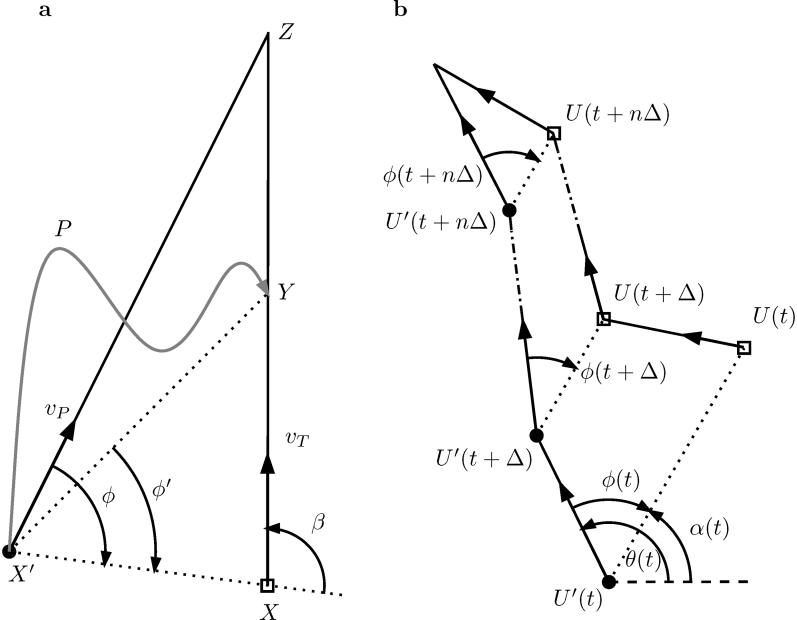
Time-Optimal Strategies to Intercept a Target(A) The target (square), which starts at position
X, moves in a straight line at a constant speed
v
T. The pursuer (solid disk), which starts at position
X′, moves at a constant speed
v
p. The straight-line intercept
X′Z, where
φ is given by
Equation 1, is the shortest intercept path possible. Quicker intercepts such as
X′Y are not possible (see text).
(B) The target (square), which starts at position
U(
t), moves erratically, changing both speed and direction. The pursuer (solid disk) starts at position
U′(
t)
. The erratic target motion can be approximated by infinitesimal constant velocity segments (such as
U(
t)
U(
t+Δ) where Δ → 0). There is no globally minimum-time intercept for truly erratic targets. A pursuer can follow a locally time-optimum path by adjusting its motion such that
φ for each infinitesimal segment is given by
Equation 1. In such a condition the bearing lines drawn from pursuer to target (
U′(
t)
U(
t), etc.) remain parallel to each other (α has a fixed value) while the target bearing (
φ) and pursuer heading direction (
θ) may change continually.
α and
θ are measured with respect to an external, fixed reference frame.